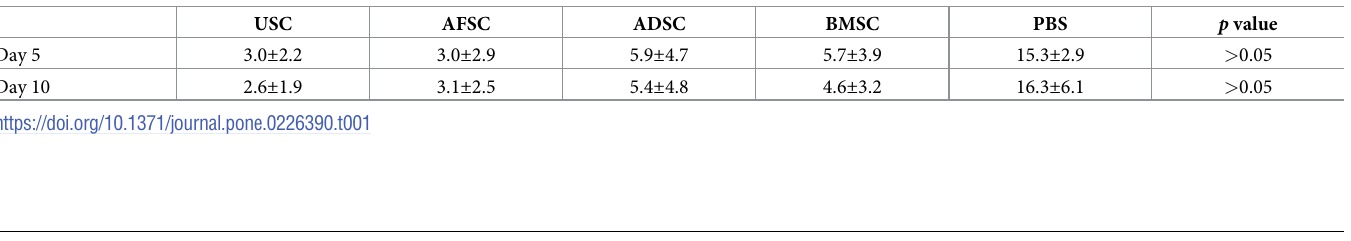
Table 1. Comparison of voiding number per hour among USC-, AFSC-, ADSC-, BMSC- and PBS-injected